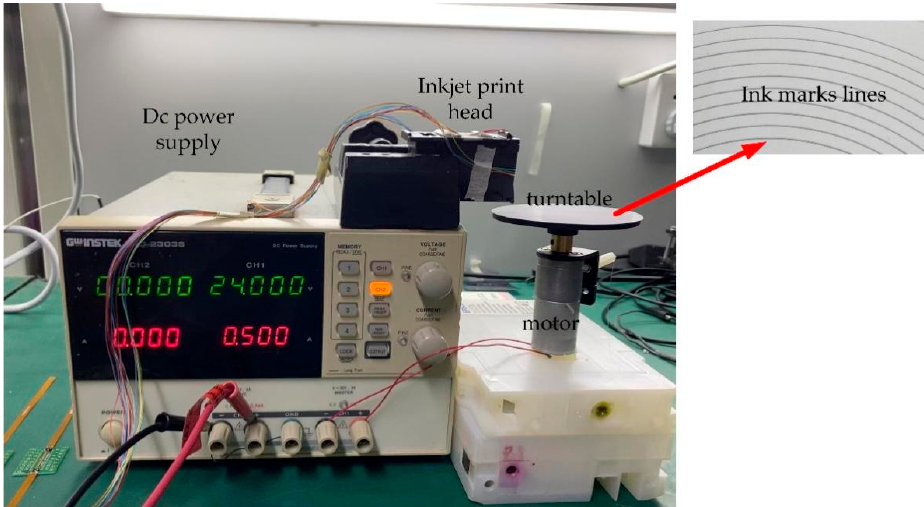
Figure 13. Establishment of experimental environment.